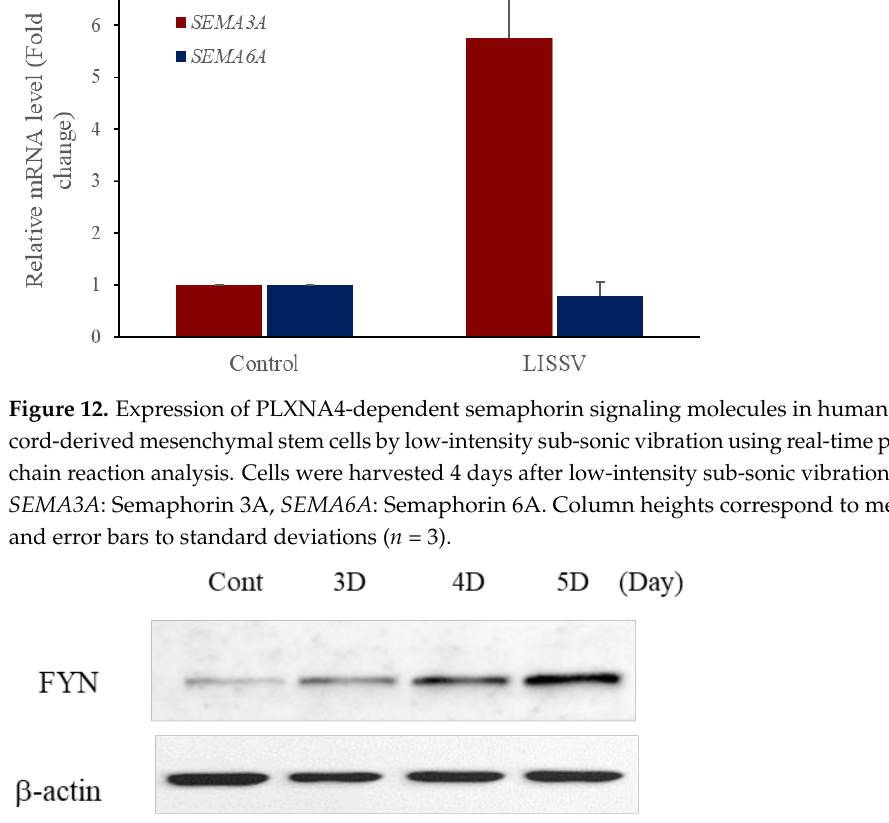
Figure 13. Expression of PLXNA4-dependent semaphorin signaling protein in human umbilical-cord- derived mesenchymal stem cells by low-intensity sub-sonic vibration. FYN: Src Family of nonreceptor tyrosine kinase p59